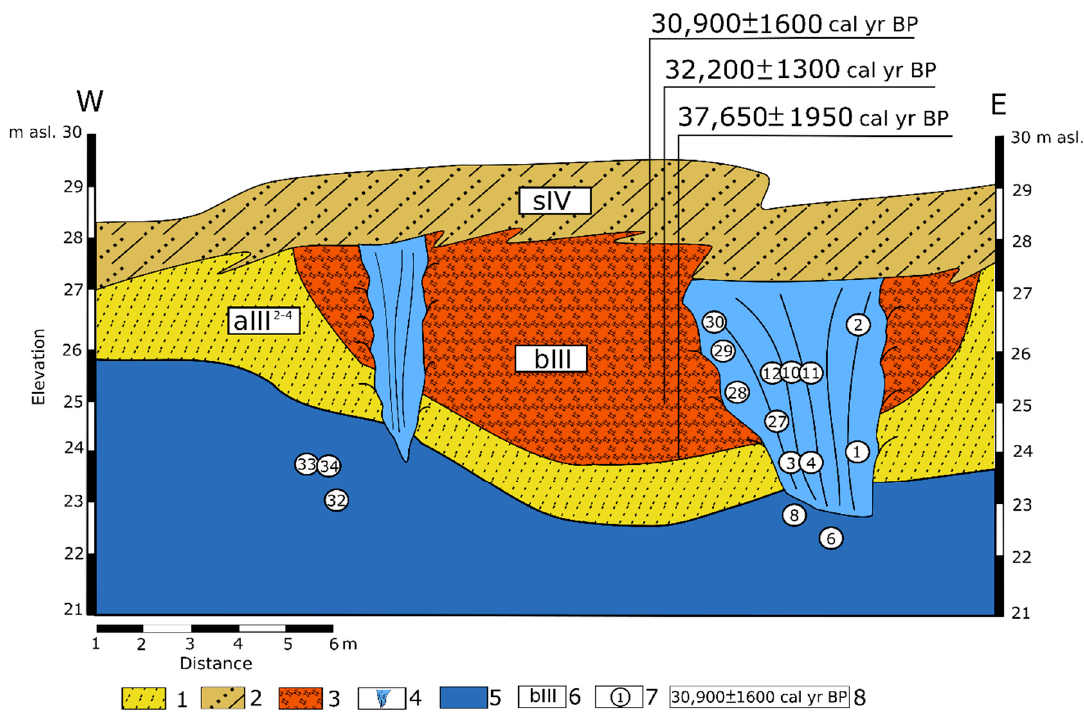
Figure 3. Schematic thermocirque section in the Vaskiny Dachi area. Legend: 1 —sandy loam; 2 —sand and sandy loam; 3 —peat; 4 —ice wedge; 5 —tabular ground ice; 6 —geological and genetic index of deposits; 7 —location and numbers of samples; 8—calibrated 14 C dates of deposits [24].